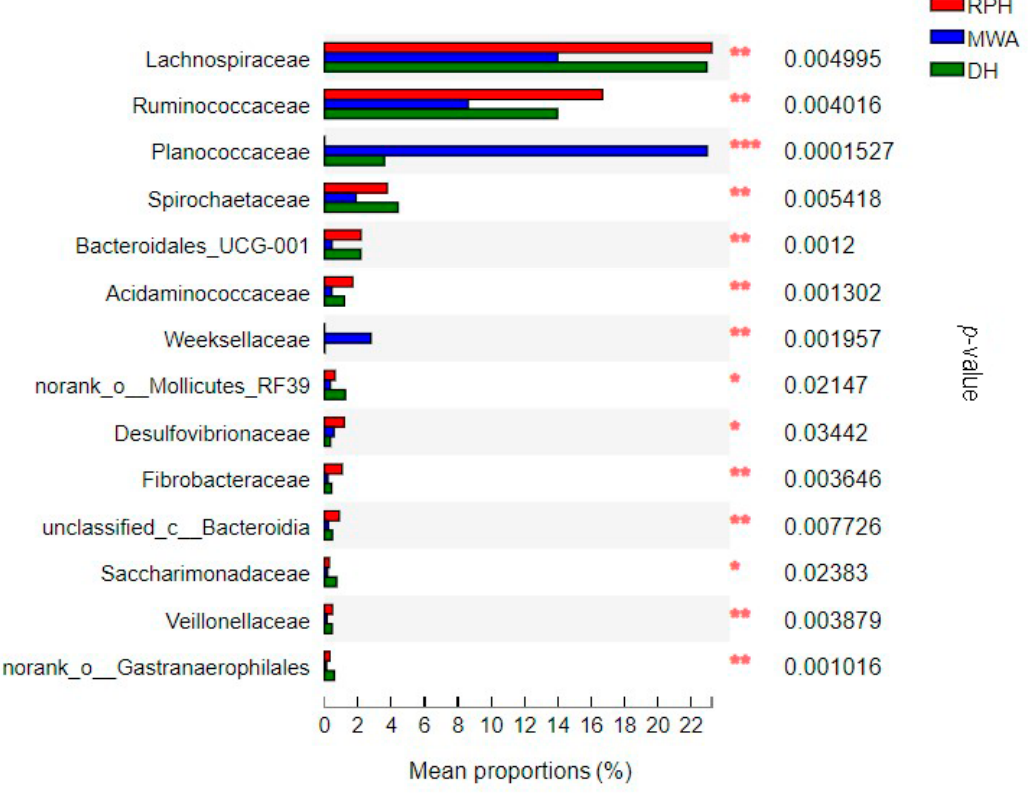
Figure 12. The bar plot shows the bacterial family with significant differences among RPH, DH and MWA. * p < 0.05, ** p < 0.01 and *** p <